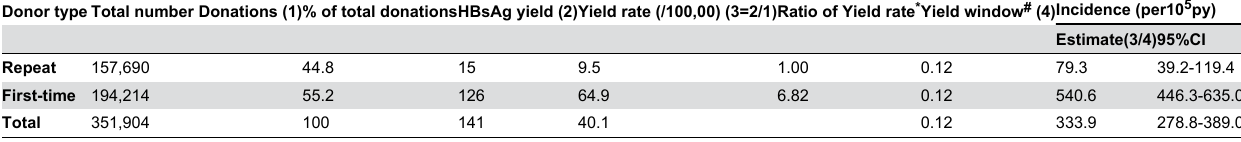
Table 6. The incidence and residual risk of TTHBV infection estimates in blood donations to Anhui from 2009 to 2011.